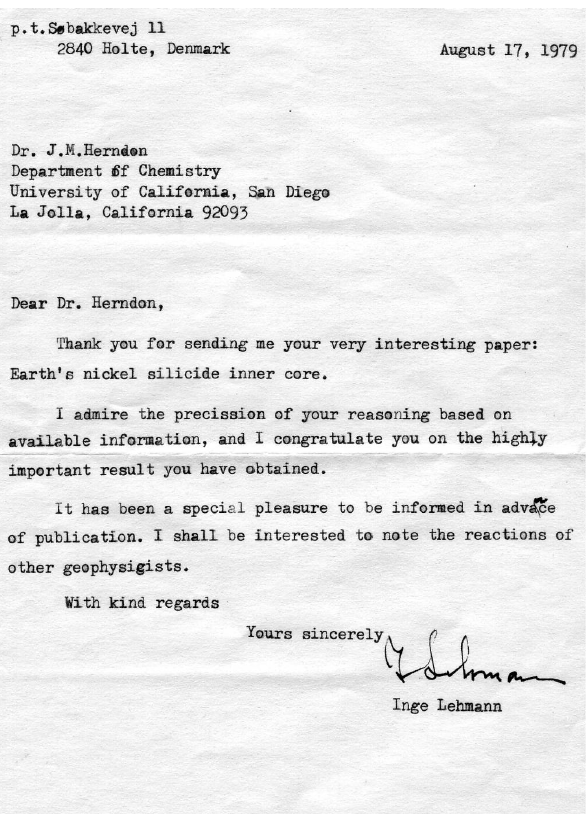
Figure 2. Scan of the congratulatory letter Inge Lehmann sent to J. Marvin Herndon.